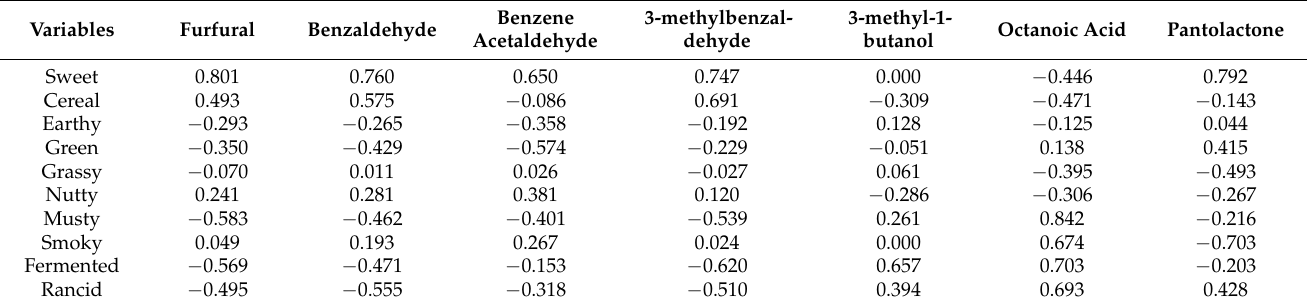
Table 2. Pearson’s correlation volatile compounds and aroma description in various fermented and nonfermented rice